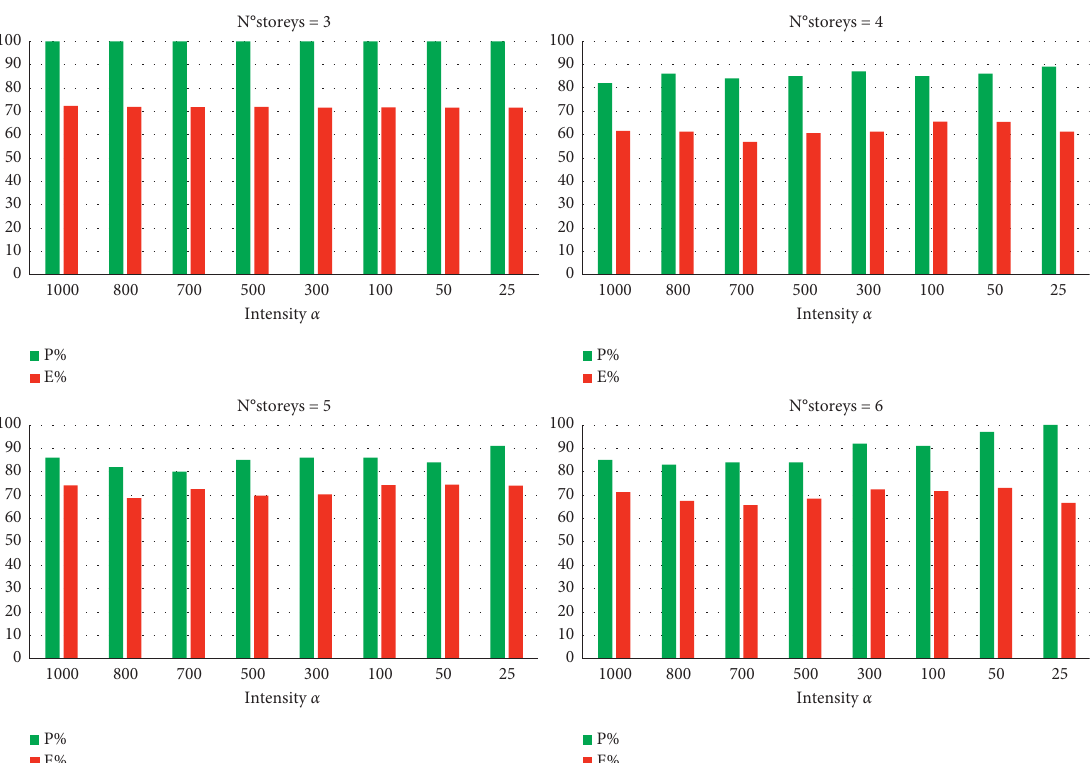
Figure 14: P% and E% for each analysed frame with assigned damage location 1 and variable